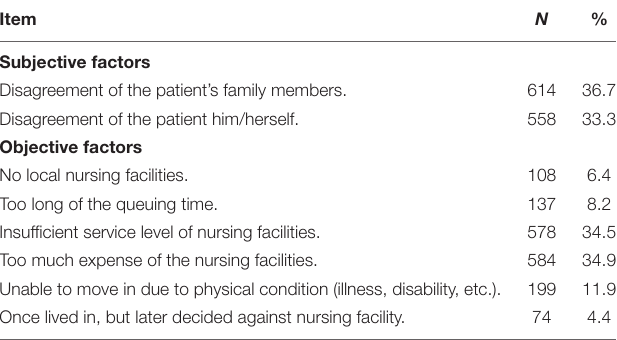
TABLE 6 | Reasons for patients not choosing to live in nursing facilities. Item N % Subjective factors Disagreement of the patient’s family members. Disagreement of the patient